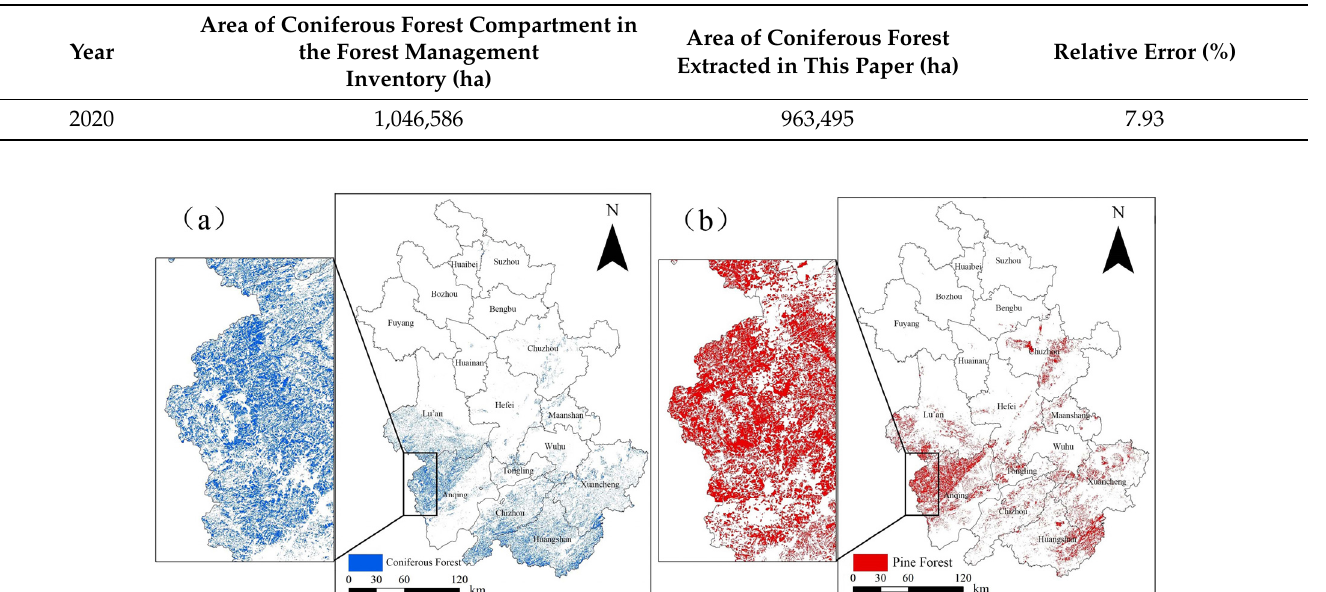
Table 5. Classification area accuracy evaluation.